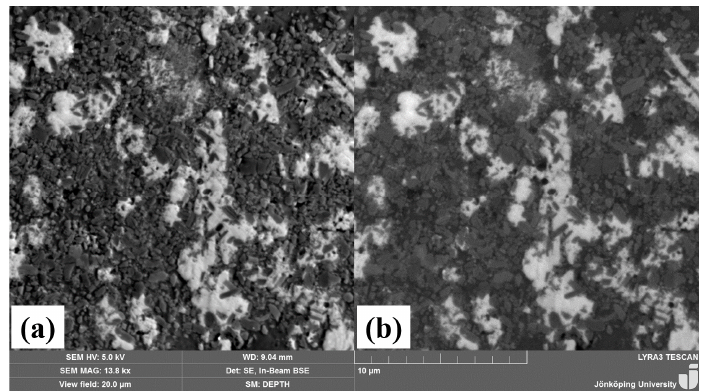
Figure 5. ( a ) SEM micrographs of secondary electron (SE) image and ( b ) backscattered electron (BSE) image of the ROI for the as-cast A205 alloy.